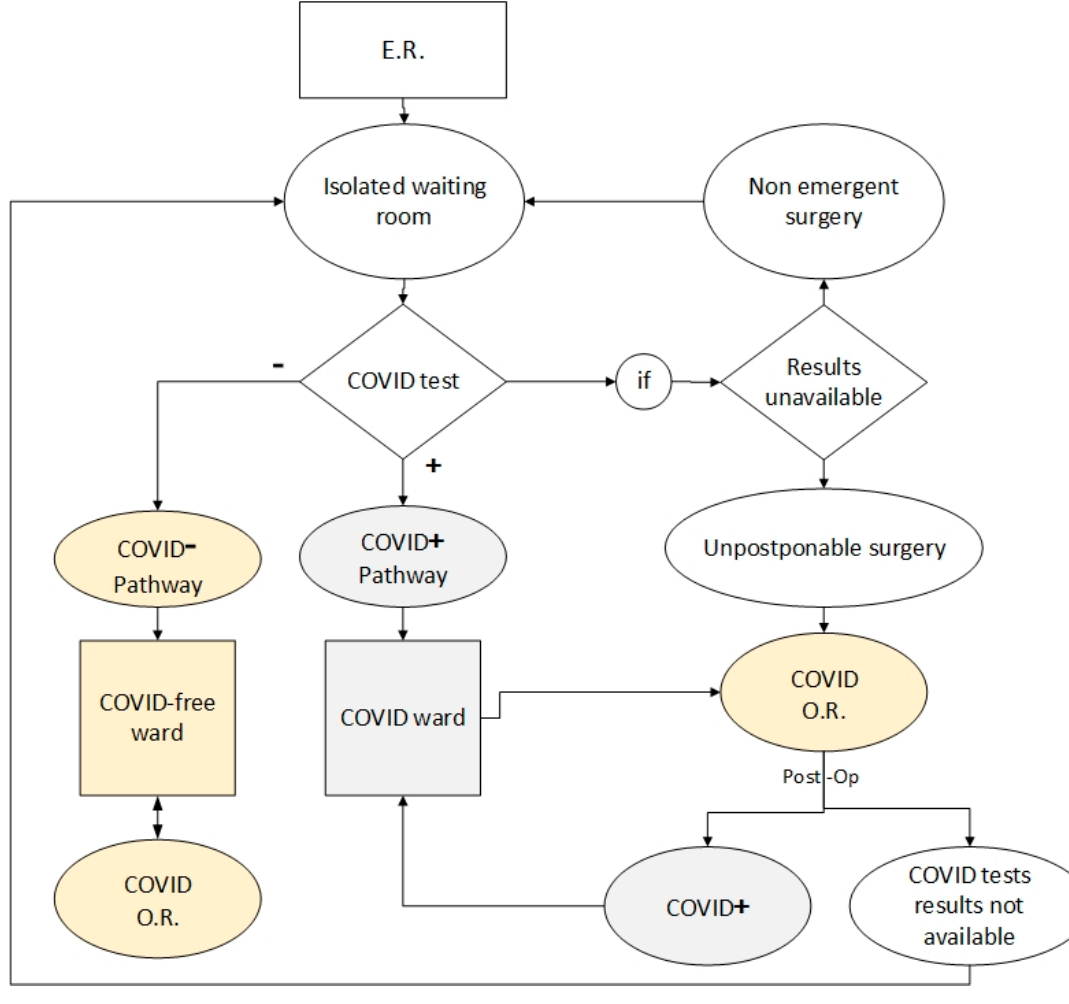
Figure 1. Workflow for orthopaedic patients, amended from [2].